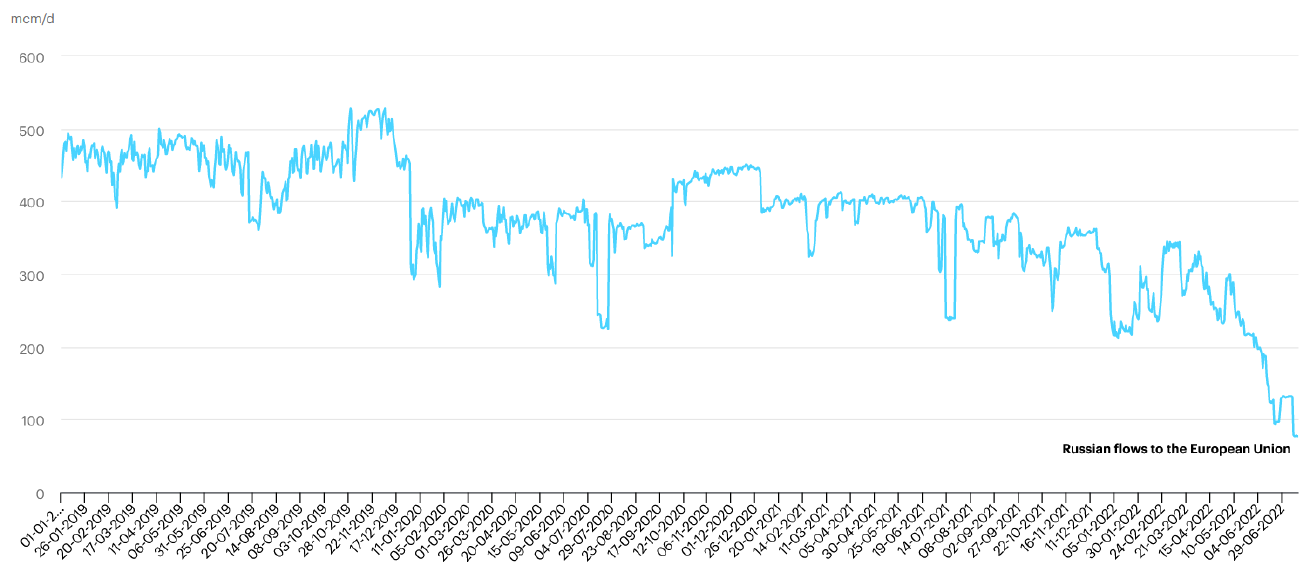
Figure 5. Russian gas flow to the European Union. These data can be found here: https://euobserver.com (accessed on 20 March 2022).